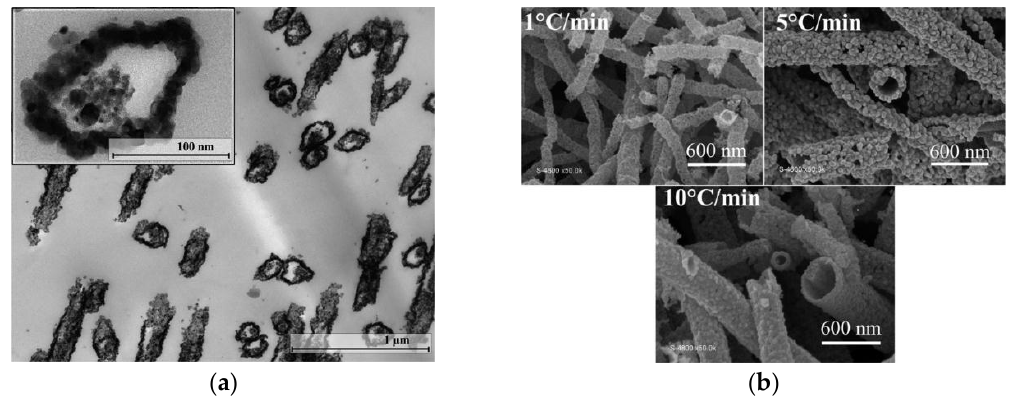
Figure 6. ( a ) TEM micrographs of microtomed sections of 5 at. % Nb-SnO 2 loose tubes obtained using 8.5 w / v % SnCl 2 . Inset: close-up of the cross-section of a loose-tube fiber. ( b ) Loose tubes of niobium-doped SnO 2 (8.5 w / v % SnCl 2 and 5 at. % Nb) prepared using heating rates of 1, 5 and 10 °C/min during